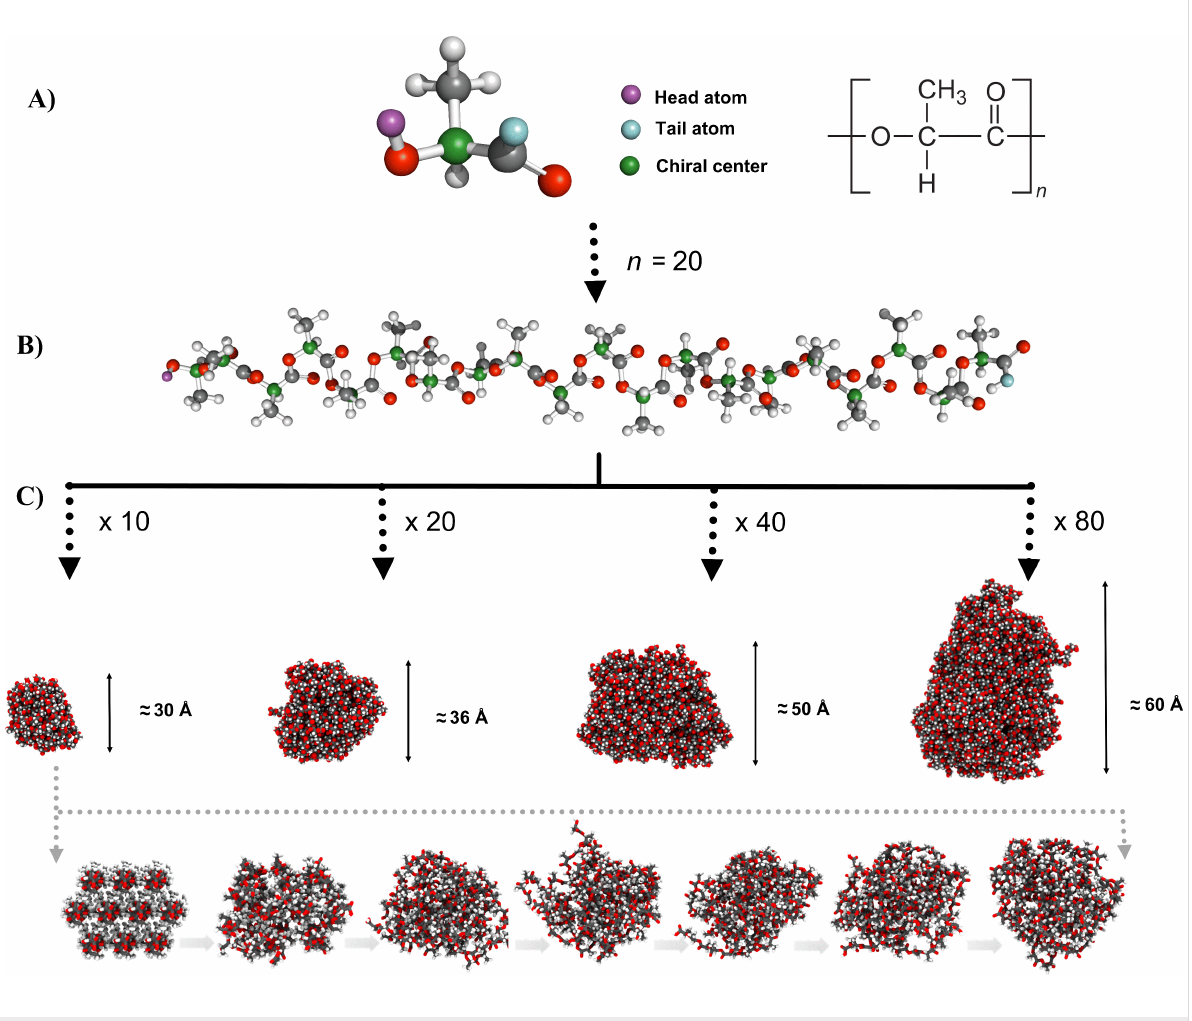
Figure 1: Schematic representation of PLA core formation process. Ball and stick representation of A) lactic acid monomer unit and atom definition for polymeric chain formation, B) poly(D,L-lactic acid) 20 monomer structure and C) van der Waals representation of 10 PLA chains with 20 monomer units after 2 ns of MD simulation and 20 PLA chains, 40 PLA chains, 80 PLA chains with 20 monomer units after 100 ps of simulation. Snapshots in time were taken from the MD simulation of PLA core formation with 10 PLA chains. Atoms are colored according to convention (carbon–gray; hydro- gen–white; oxygen–red) except the head, tail and chiral